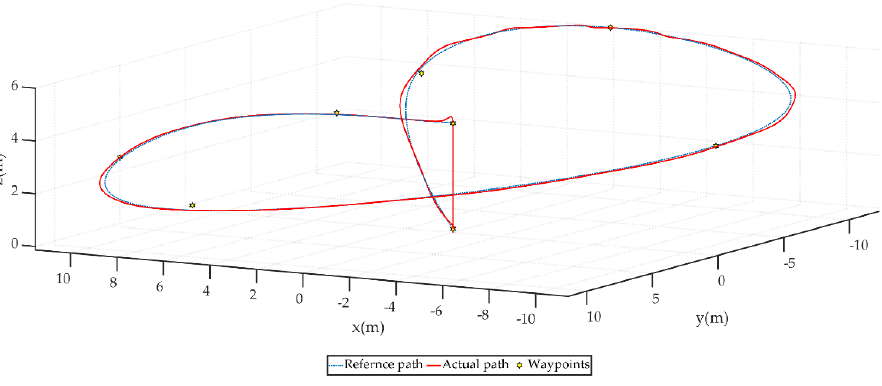
Figure 17. The path followed by the UAV.